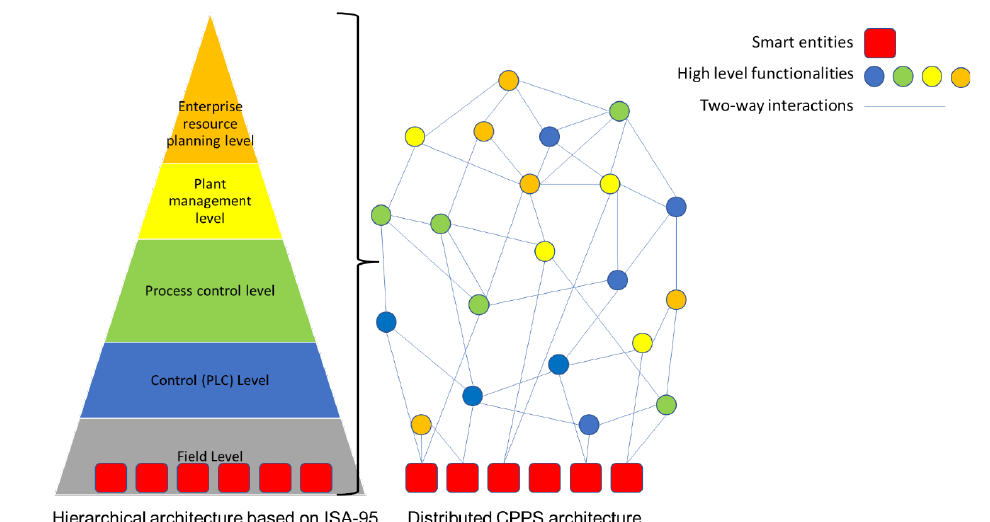
Figure 11. Evolution of hierarchical ISA-95 architecture to a CPPS distributed model.